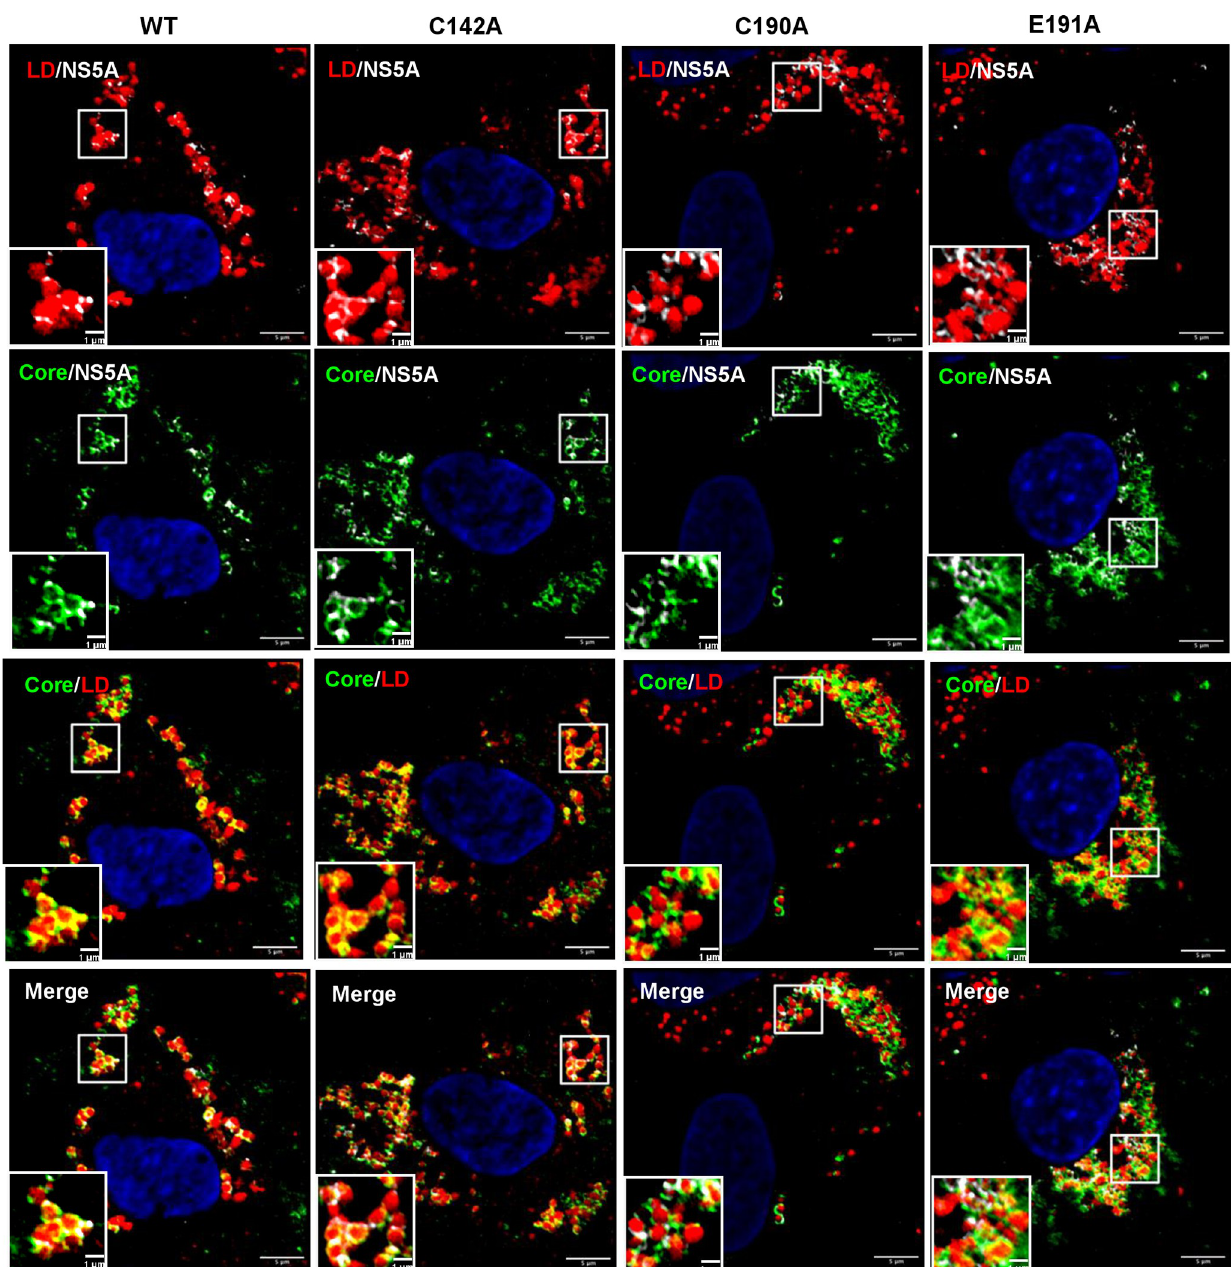
Fig 7. Co-localisation between NS5A, Core and LD in PKR-silenced Huh7.5 cells. Huh7.5 cells silenced for PKR expression were electroporated with mJFH-1 WT and DI mutant C142A, C190A and E191A RNAs and seeded on to coverslips. Cells were stained at 72 hpe with sheep anti-NS5A (white), rabbit anti-Core (green), BODIPY 558/568-C12 (red) and DAPI. Co-localisation was observed using Airyscan microscopy. Representative images are shown. Representative images of mock electroporated cells are shown in S6B Fig. Scale bars are 5 μ m and 1 μ m (insets).